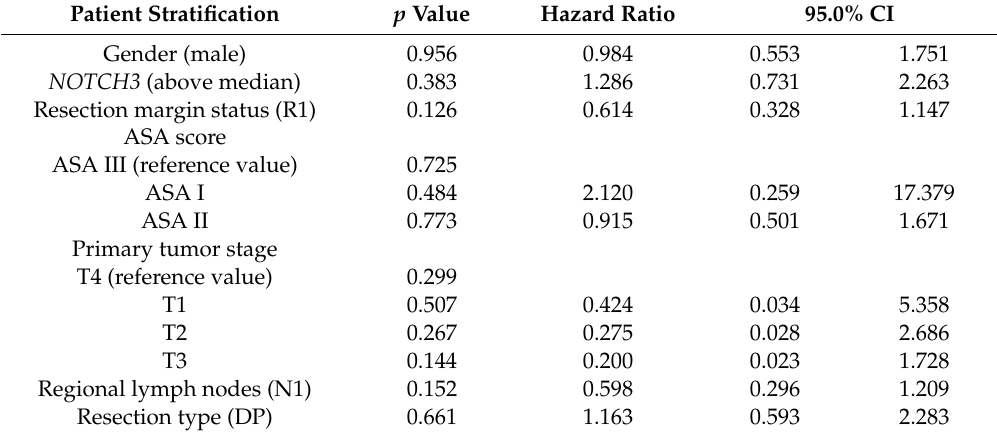
Table 3. Results of multivariate analysis (Cox’s proportional hazards model) of the e ff ects of clinical and pathological characteristics and NOTCH3 mRNA expression on patients’